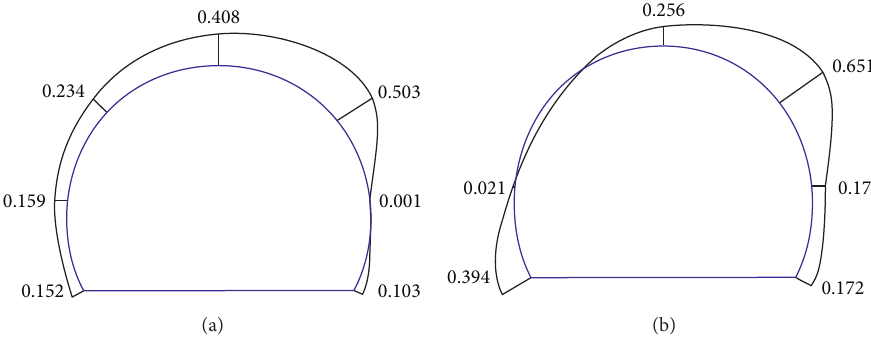
Figure 15: Circumferential distribution of surrounding rock pressure. (a) DK390 +163. (b) DK390 +159.